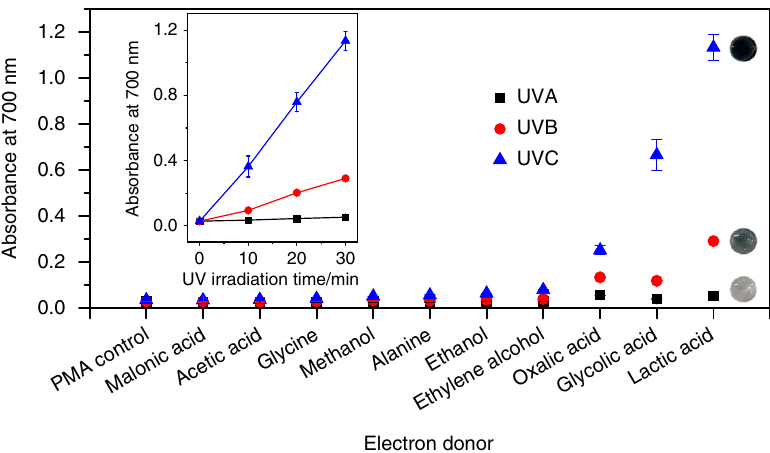
Fig. 2 Comparison of different e − donors in reducing PMA on UVR excitation. The main panel compares the ability of different e − donors in reducing PMA after 30 min of UVR excitation. The photographs of the colored solutions post-UVR exposure in the presence of lactic acid are shown. The inset shows the UVR exposure time-dependent response of PMA in the presence of lactic acid. The concentrations of PMA and the e − donor correspond to 1 and 10 mM, respectively, and the UVR intensity is consistent as 15 W m – 2 resulting in an effective UV dose of 27,000 J m – 2 over 30 min. Each data point represents an average of the colorimetric response obtained from three independent samples and the associated standard deviation